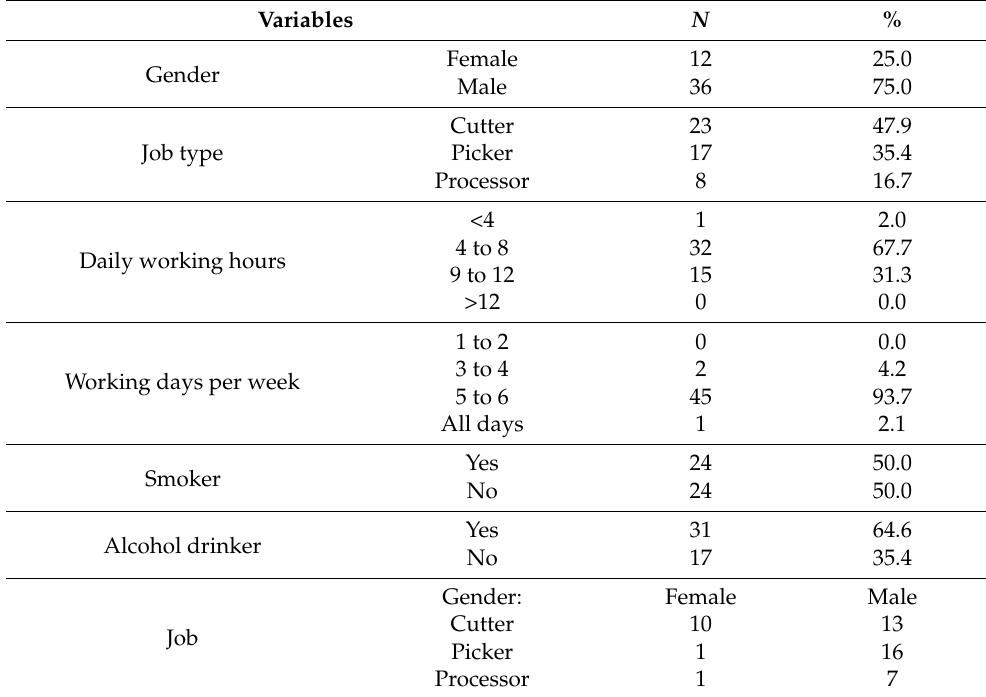
Table 1. Demographic and laboral data of participants in nominal and categorical variables.